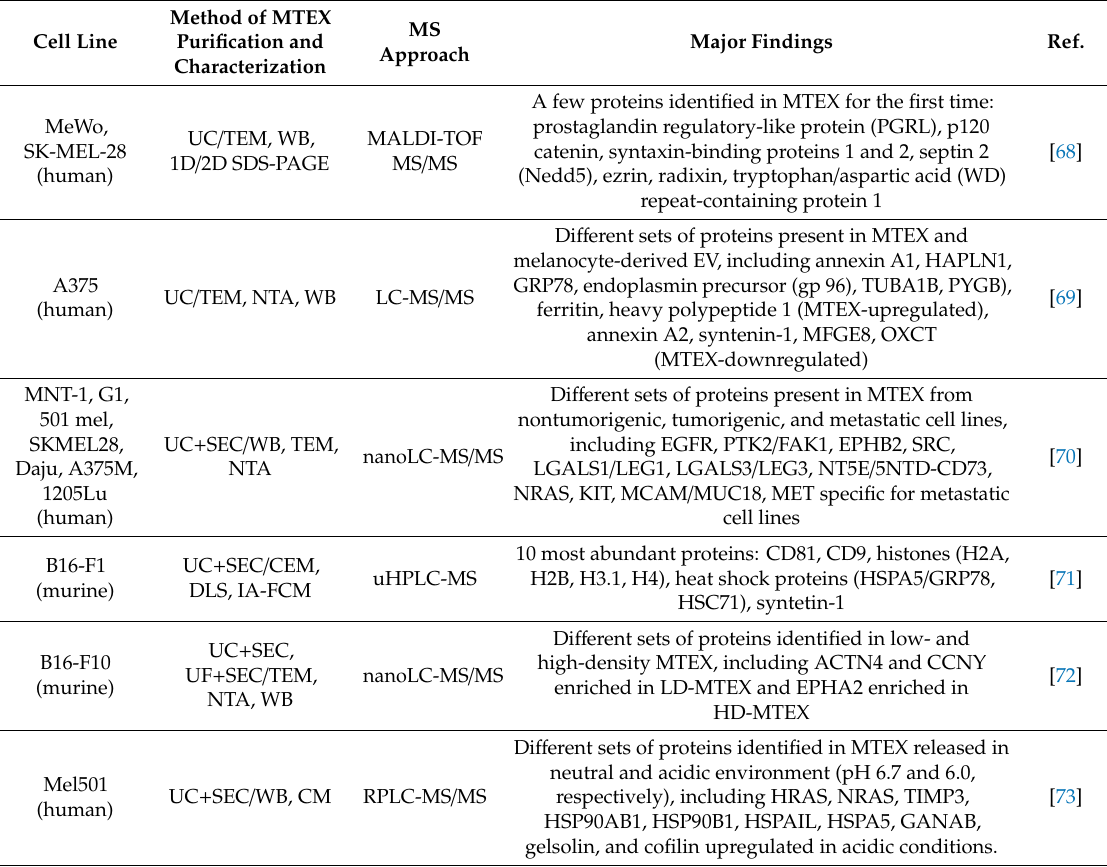
Table 1. Proteomics Profiling of Melanoma Cell-Derived Exosomes (MTEX) Released in Vitro by Melanoma Cell